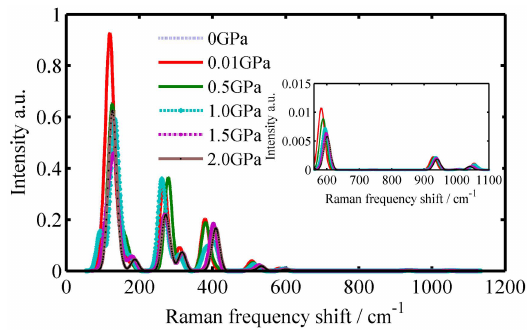
Figure 6. The Raman spectrums of Pb 4 + -doped α -SiO 2 crystal under di ff erent pressure at 127